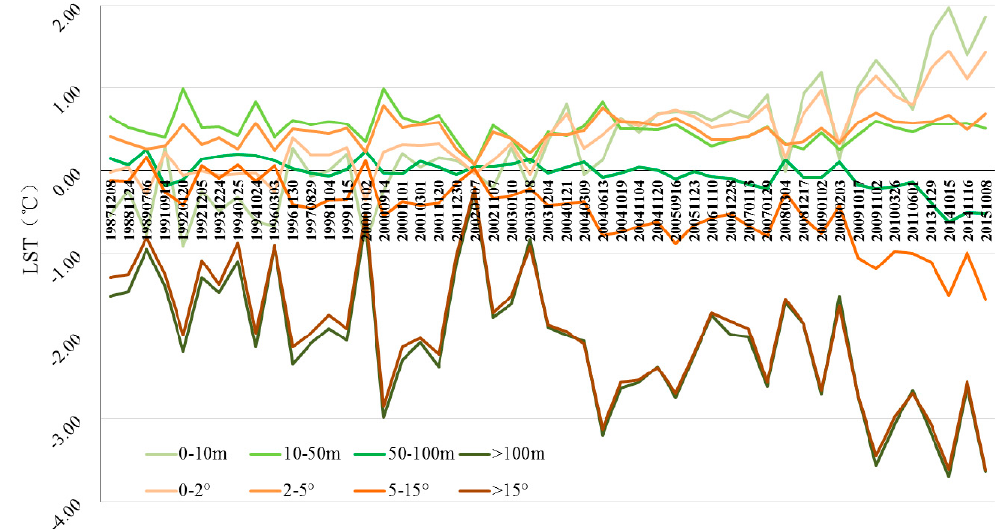
Figure 9. Land surface temperature deviations grouped according to different elevation and slope ranges.